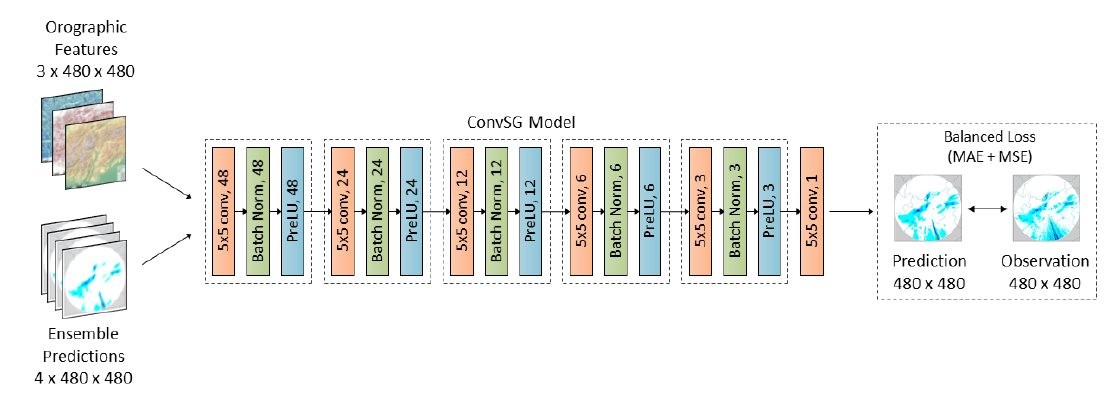
Figure 7. The architecture of the deep learning ConvSG